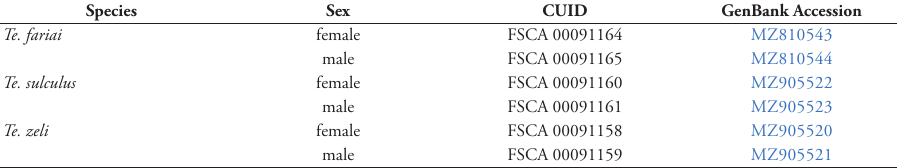
Table 1. Specimens for which new DNA barcodes data were generated. Species Sex Te.